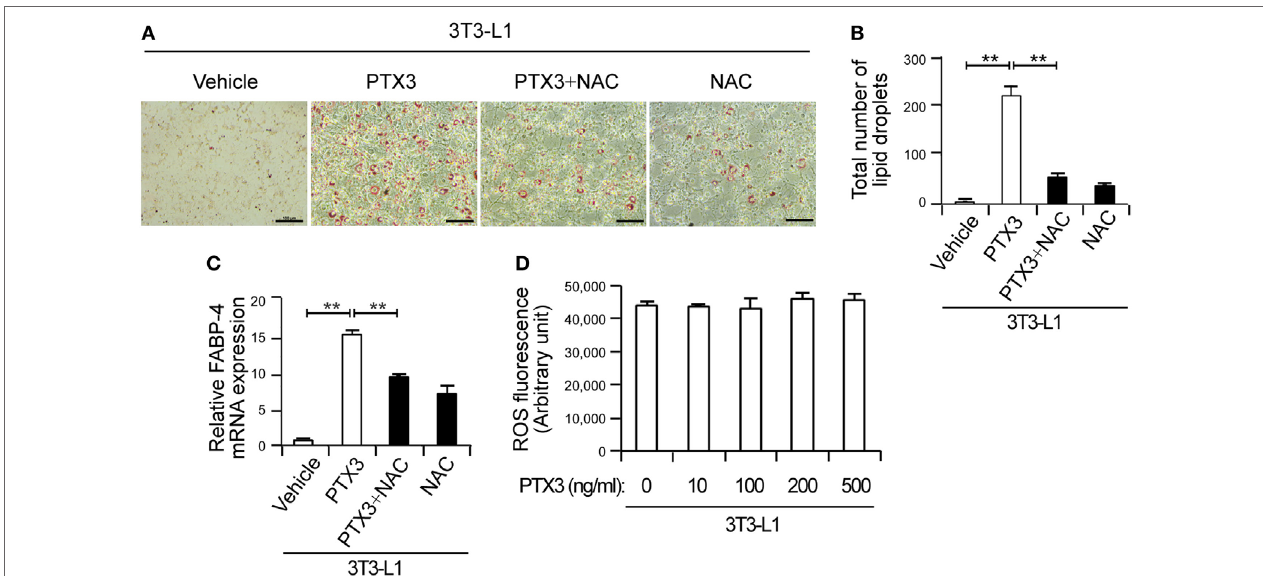
FigUre 4 | Pentraxin 3 (PTX3)-mediated adipogenesis is inhibited by antioxidants. (a) Antioxidants prevent PTX3-mediated increases in lipid accumulation in 3T3 cells. Oil-Red-O staining of 3T3 cells treated with PTX3 with or without the antioxidant N -acetylcysteine (NAC) (10 mM) is shown. Scale bar: 100 microm (µM). (B) Quantification of the total number of lipid droplets in (a) ( n = 5). (c) NAC inhibits PTX3-mediated increases in fatty acid binding protein-4 (FABP-4) expression. FABP-4 expression was analyzed using quantitative real-time PCR ( n = 4). (D) PTX3 has no effect on reactive oxygen species (ROS) production in 3T3-L1 cells. The cells were stained with 2 ′ , 7 ′ -dichlorofluorescin diacetate for 30 min at 37°C and subsequently treated with the indicated concentrations of PTX3 for 4 h. ROS levels were detected using a fluorescent plate reader ( n = 3). Data are representative of three independent experiments. ** p < 0.005 compared with the vehicle control. p values were calculated using the Kruskal–Wallis test. Data values represent the mean ±